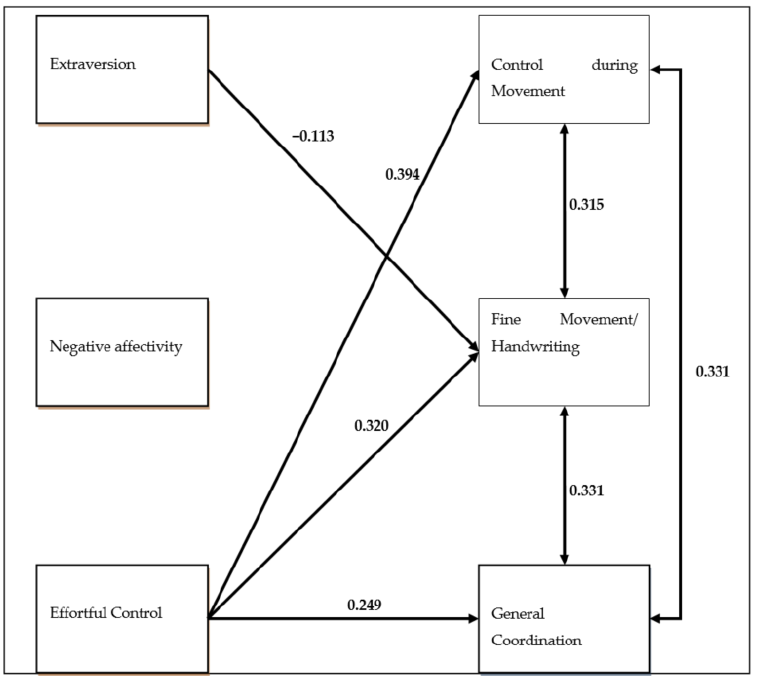
Figure 1. Path model displaying relationships between the components of temperament and the indicators of Developmental Coordination Disorder. indicators of Developmental Coordination